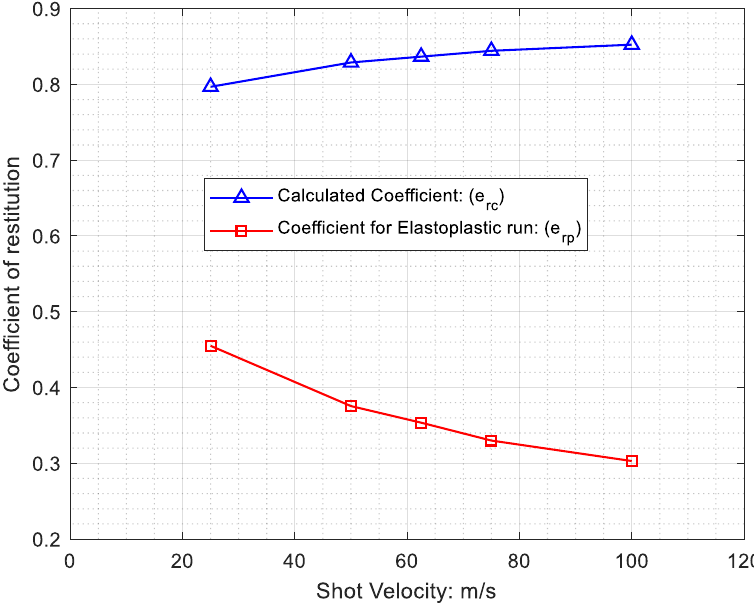
Figure 5. A plot of the Coefficient of Restitution (CoR) obtained using the Finite Element Method (FEM) and the calculated CoR that is implemented in the Discrete Element Method (DEM), against shot velocities.